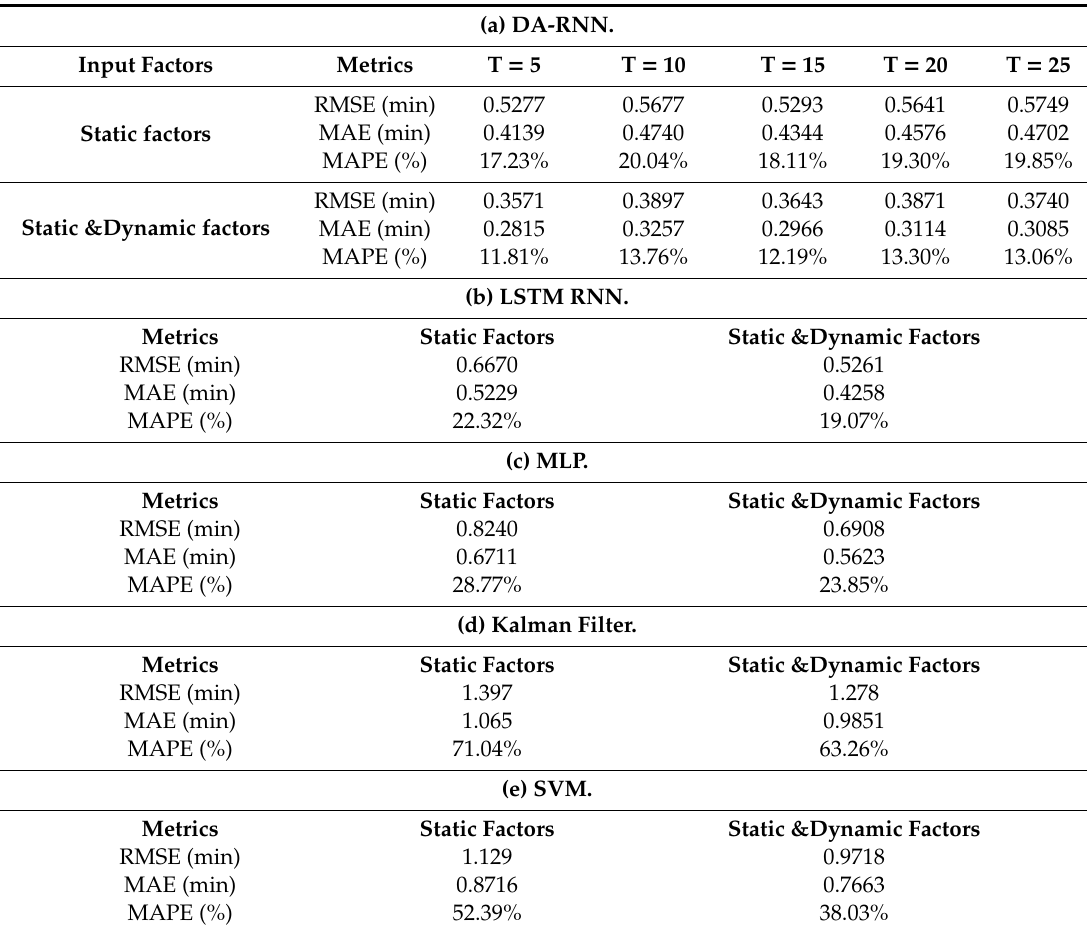
Table 1. Comparisons among di ff erent methods used on our dataset. (a) DA-RNN.